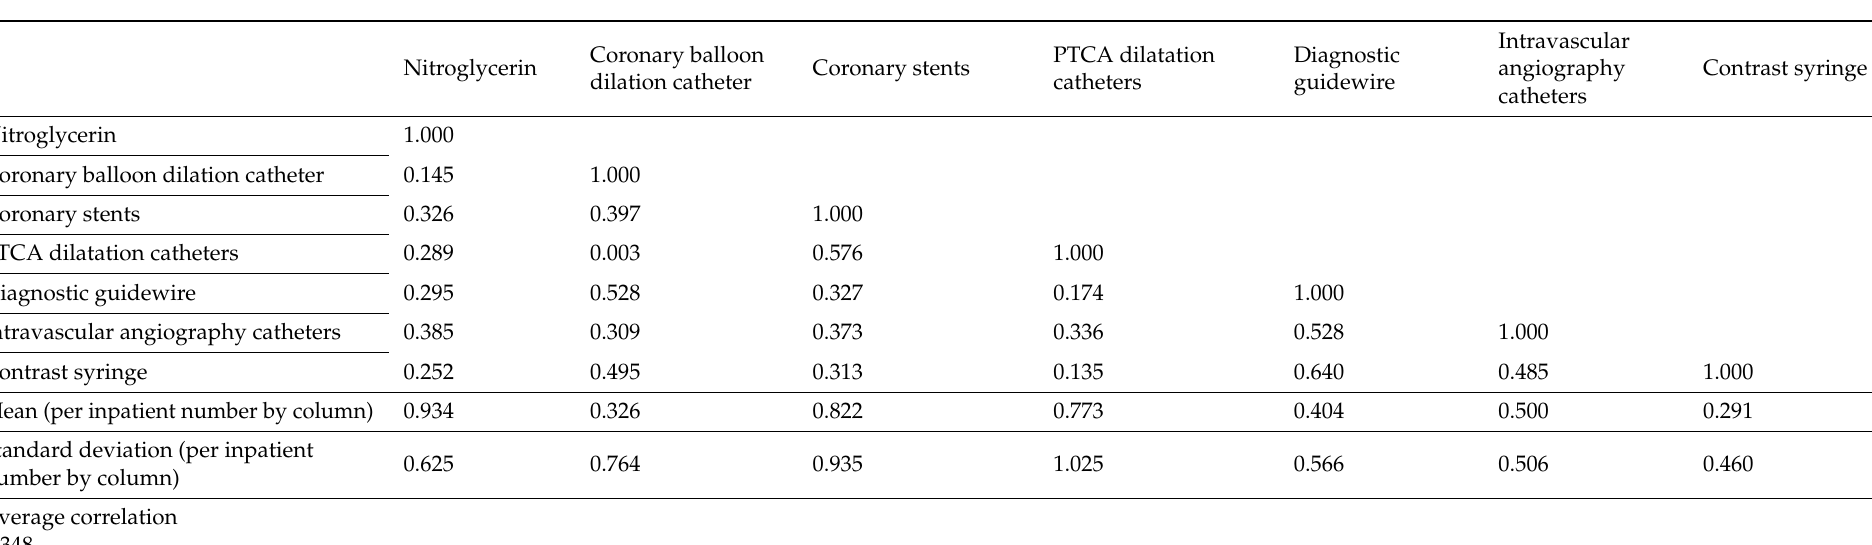
Table 8. The comparison of the correlation analysis results for resuscitation medicine and surgical related consumables used for Scenario Two’s study using counts